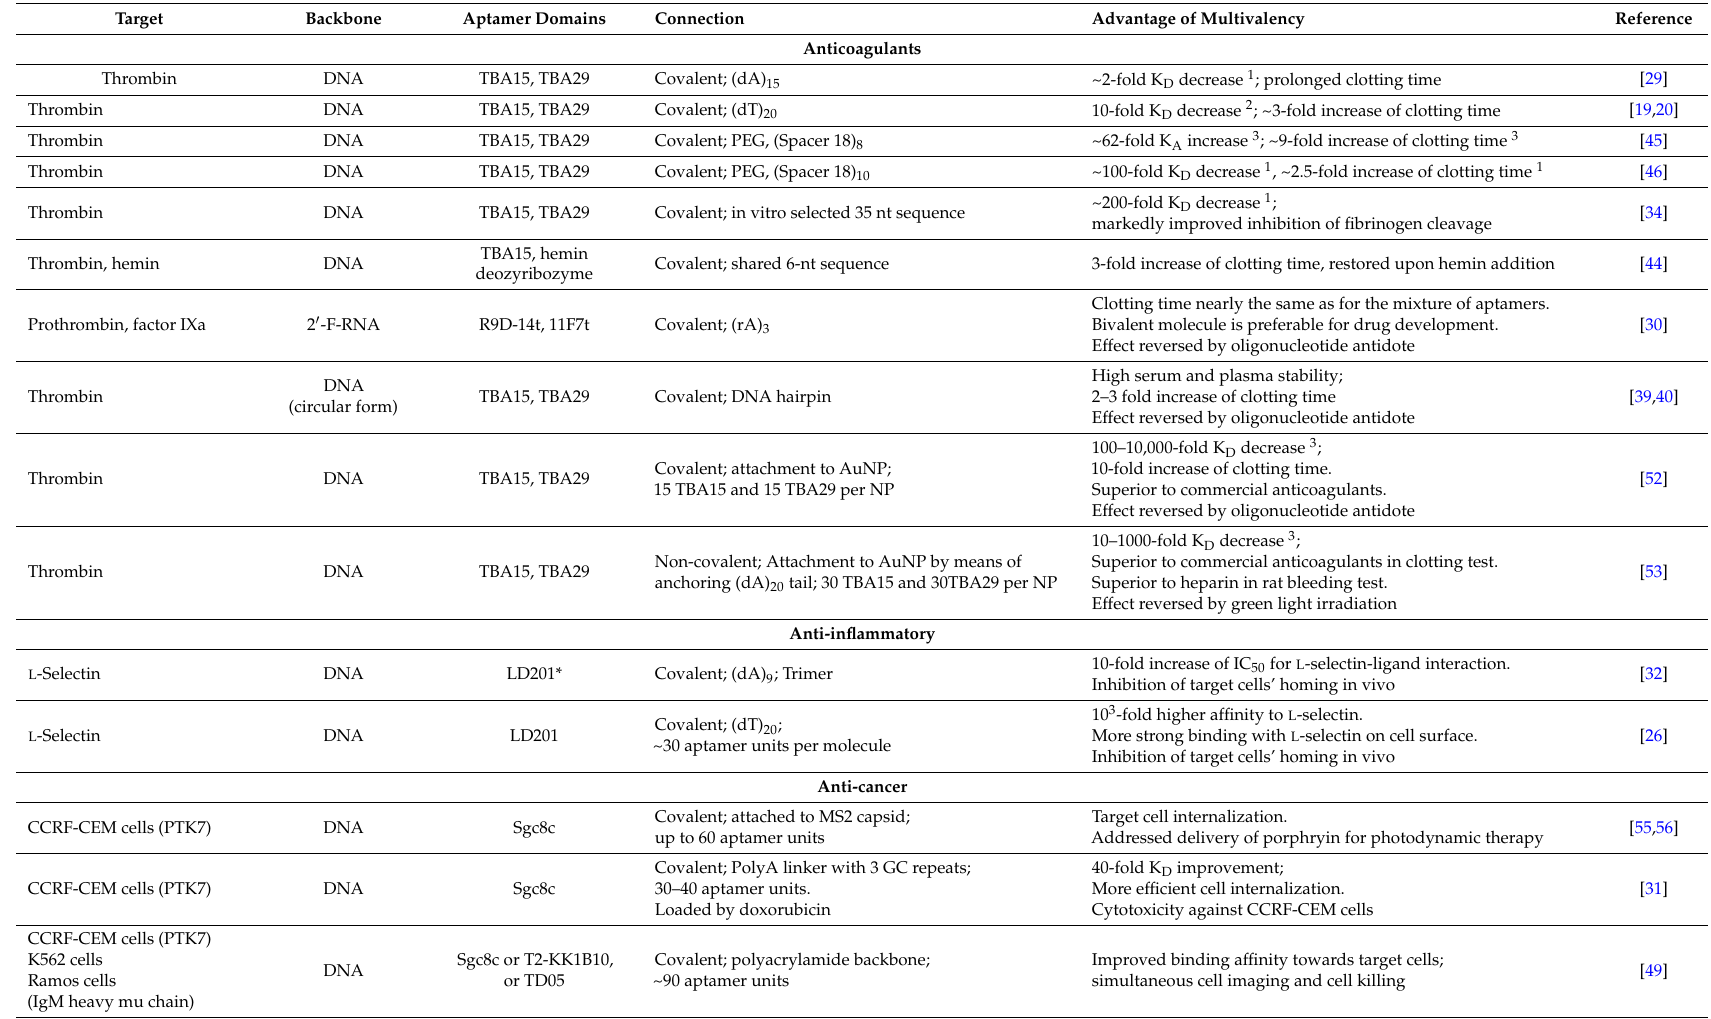
Table 2. Summary of multivalent aptamer constructs for therapeutic